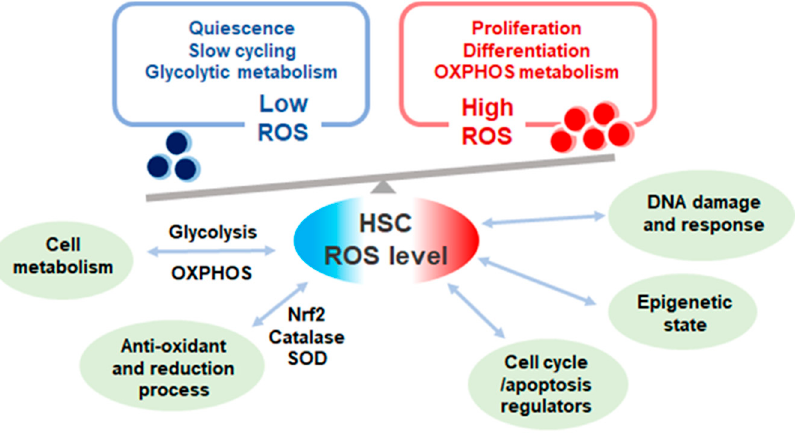
Figure 1. The levels and effect of reactive oxygen species (ROS) in quiescent and proliferative hematopoietic stem cells (HSCs). ROS level in HSCs varies according to cell cycle state. Quiescent HSCs depend on glycolytic metabolism exhibit low ROS level while proliferative HSCs depend on oxidative phosphorylation (OXPHOS) metabolism with high ROS production. ROS levels affect multiple cell functions in HSCs and heavily influences HSC fate.